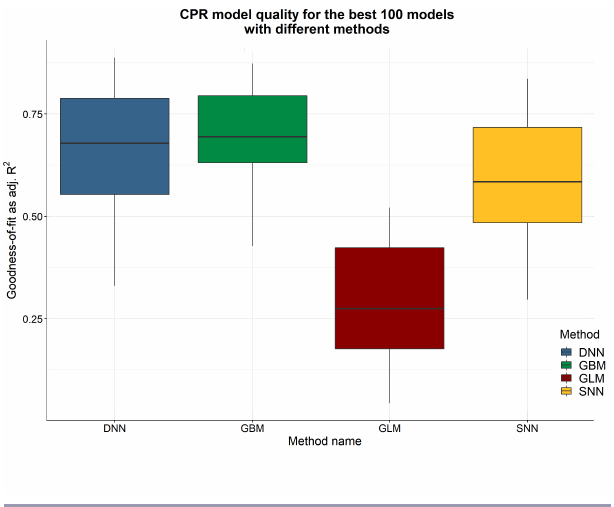
Fig. 2 . Model quality of the best 100 models for four methods (CPR: common-pool resources; DNN: deep neural network; GBM: gradient boosting machine; GLM: generalized linear model; SNN: shallow neural